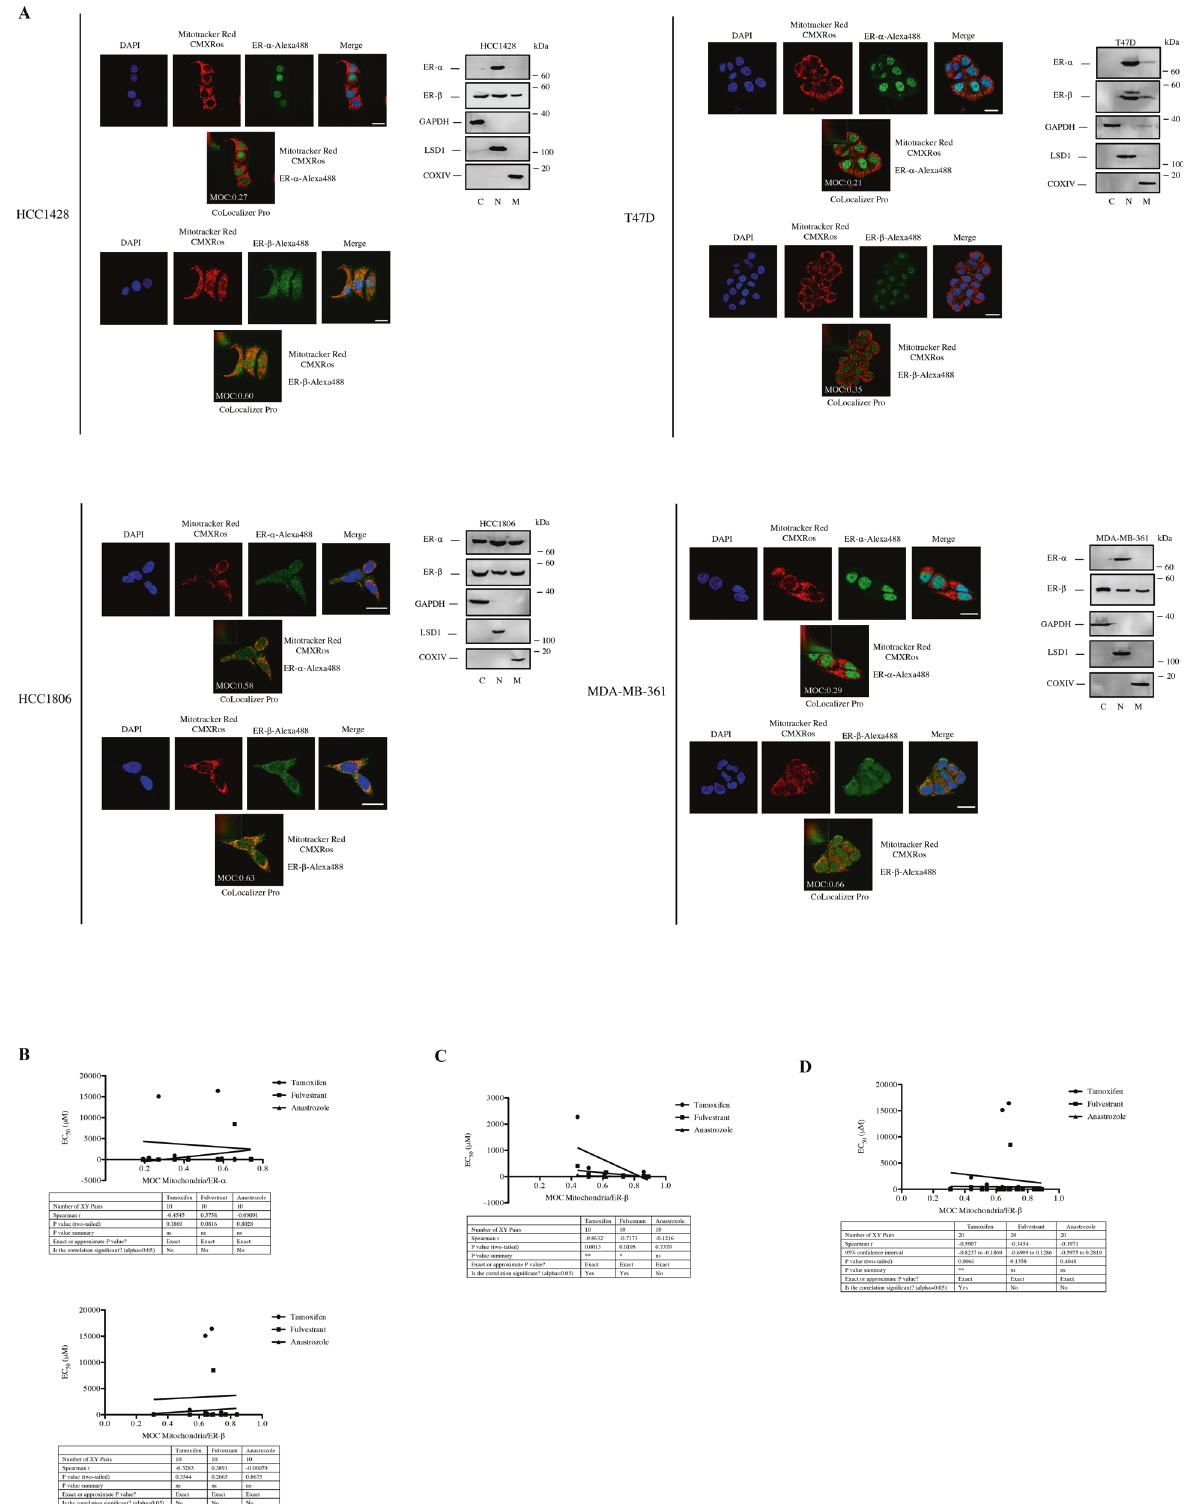
Mitochondrial ER- α and ER- β differentially modulate response to endocrine therapy and mitochondrial priming To delineate the direct contribution of mitochondrial ER- α and ER- β in endocrine therapy response and mitochondrial priming in breast cancer cells, we depleted ER- β in ER- α ( − ) HC1187,